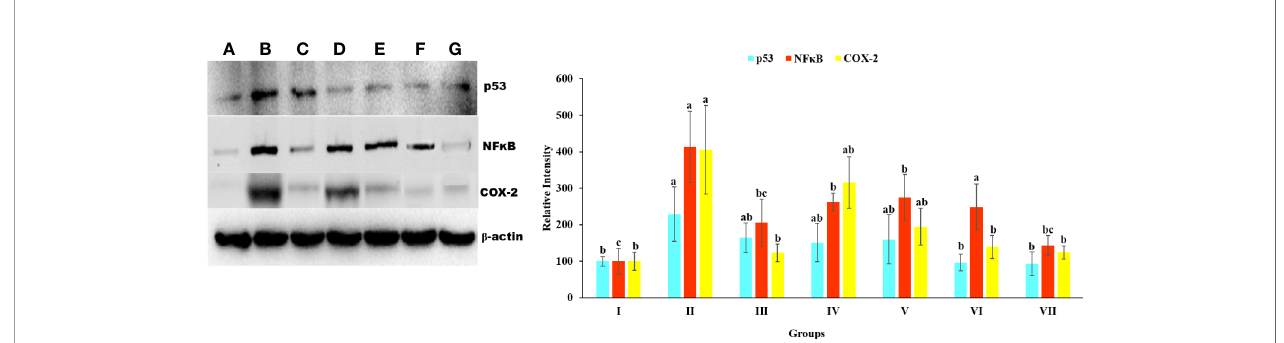
FIGURE 9 | Expression level p53, NF k B, and COX-2 protein in liver homogenate of Wistar rats detected using Western blotting. (A) Control group (tap water ad libitum) (GI), (B) CCl 4 : Olive oil (1:1; 1mL kg -1 b.wt.) induced elevation in the expression level of p53 was noted. (C) Silymarin (100 mg kg -1 b.wt.) + CCl 4 , (D) low dose (50 mg kg -1 b.wt.) + CCl 4 , (E) medium dose (100 mg kg -1 b.wt.) + CCl 4 , (F) High dose (200 mg kg -1 b.wt.) + CCl 4, (G) Negative (only extract 100 mg kg -1 b/wt.). Histograms showing densitometric analysis of p53, NF k B, and COX-2 protein bands using western blotting. Band density was measured and normalized to that of b -actin. Values are expressed as mean ± SE at level of signi fi cance p ≤ 0.05. Data labels with different letters represent signi fi cant difference